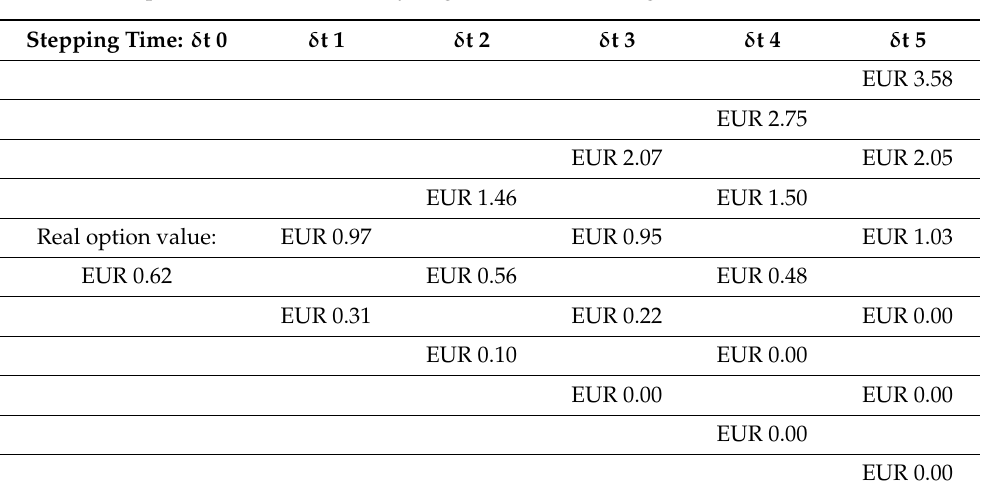
Table 8. Real options lattice: a value of synergies of Luminor merger (in € billion). Stepping Time: δ t 0 δ t